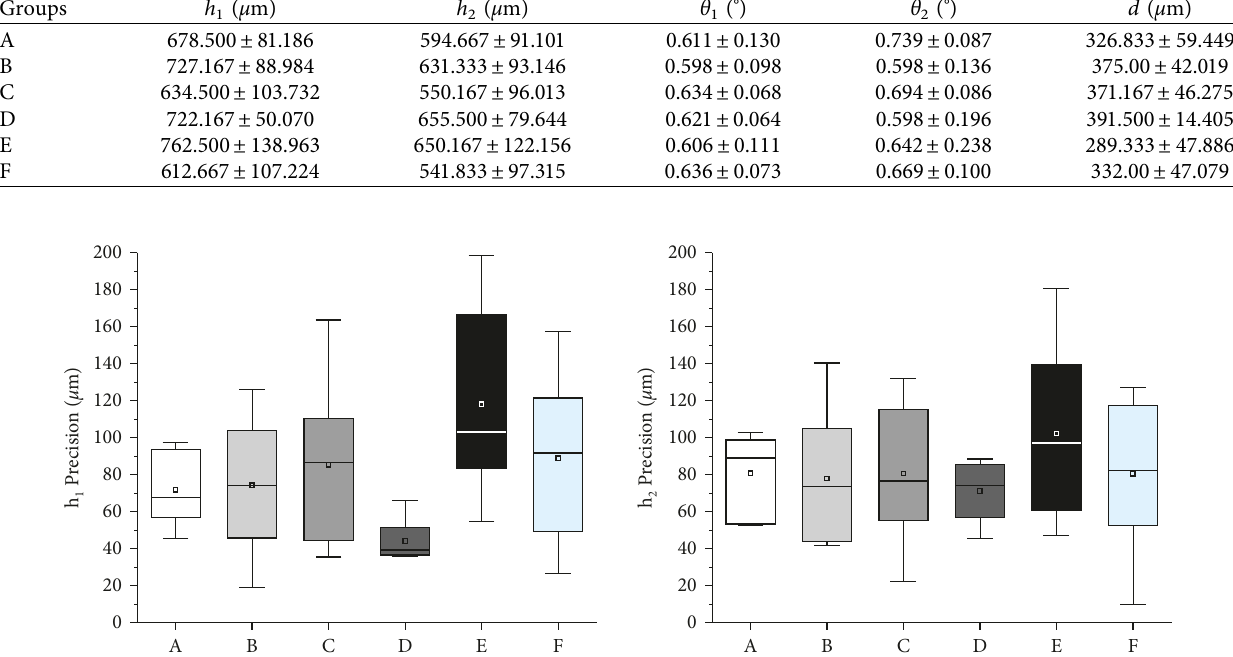
Figure 8: Boxplots of precision for height ( h